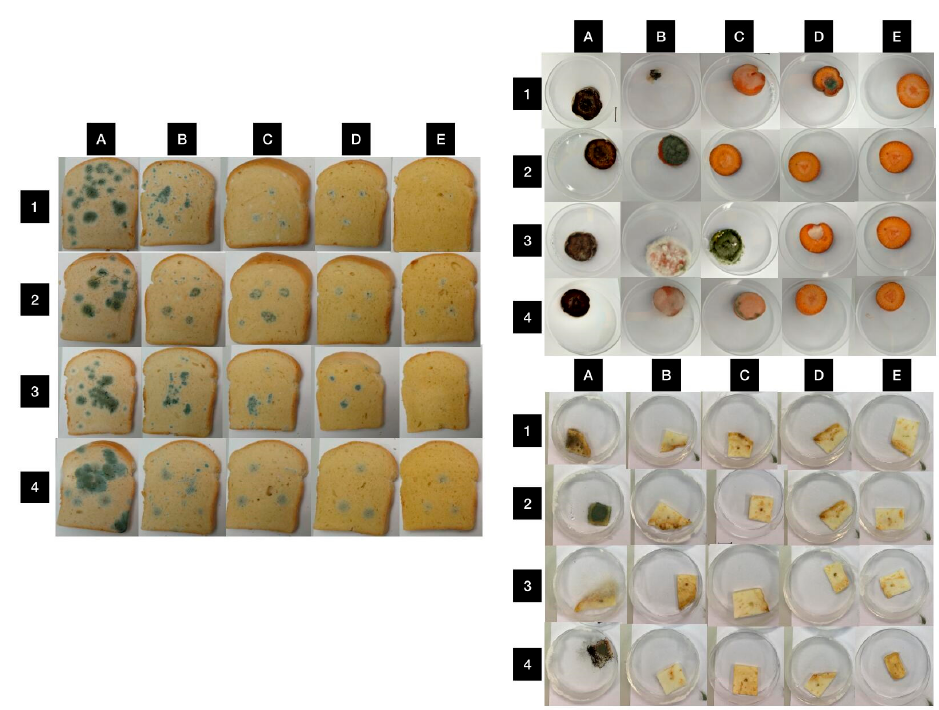
are considerably different, statistically ( p < 0.05).